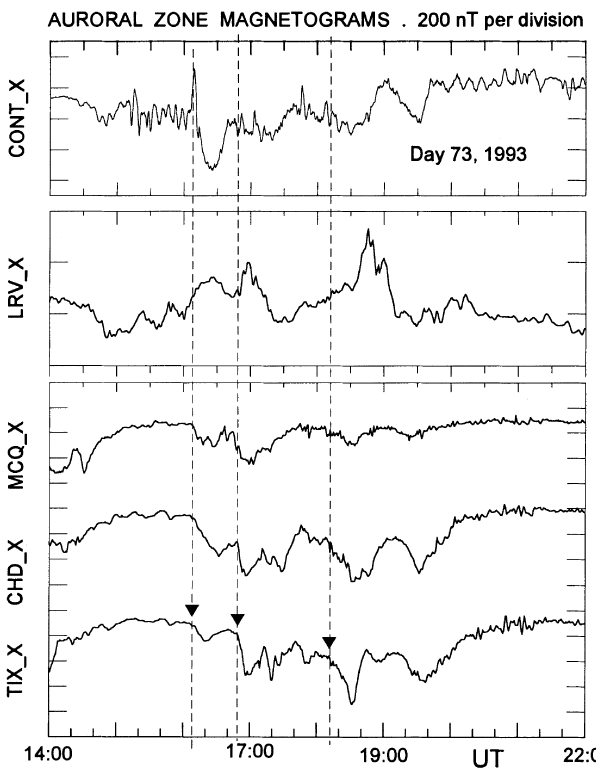
Fig. 12. Recordings of common-scale magnetometer data (200 nT per division) obtained from auroral ground-based stations during the interval 14:00–22:00 UT on day 73, 1993. The marked arrow at (cid:24) 16:48 UT corresponds to a distinct substorm onset. The expansion phase of the same substorm is detected on board GEOTAIL at (cid:24) 16:52 UT. The flow reversal at (cid:24) 18:10 UT may correspond to the recovery phase of this marked substorm. From top to bottom the stations are the Contwoyto Lake, Leirvogur observatory, MCQ, Cape Chelyskin